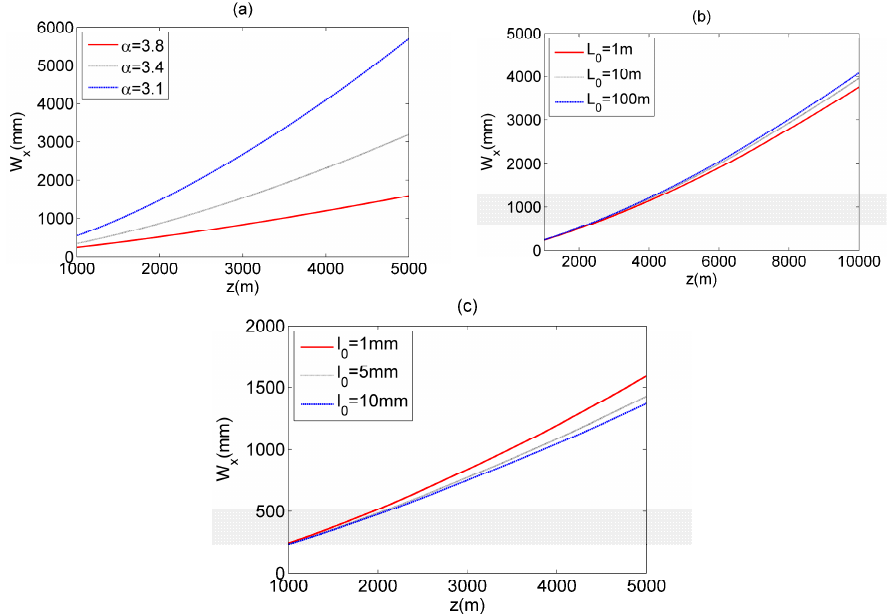
Figure 8. The W x of N × D MGSM array beams propagating through non-Kolmogorov turbulent atmosphere. ( a ) di ff erent α , ( b ) di ff erent L 0 , and ( c ) di ff erent l 0